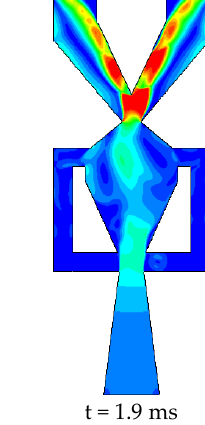
Figure 7. Mach number distribution at different times in model M 8, 6.